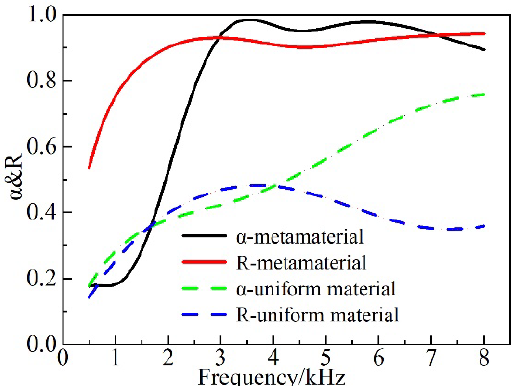
Figure 5. Forward absorption coefficient ( α ) and backward reflection coefficient (R) between the proposed AM and the uniform material.